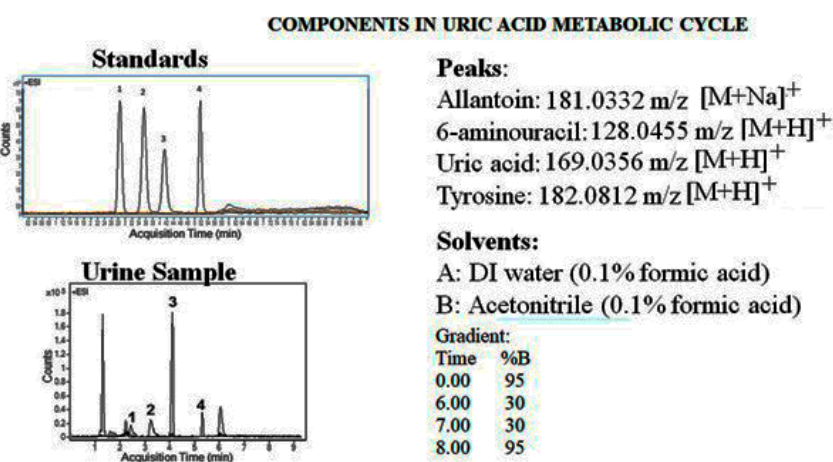
Figure 9. Analysis of components in the uric acid on the Cogent Diol stationary phase in the aqueous normal-phase mode. Adapted from Reference [67].